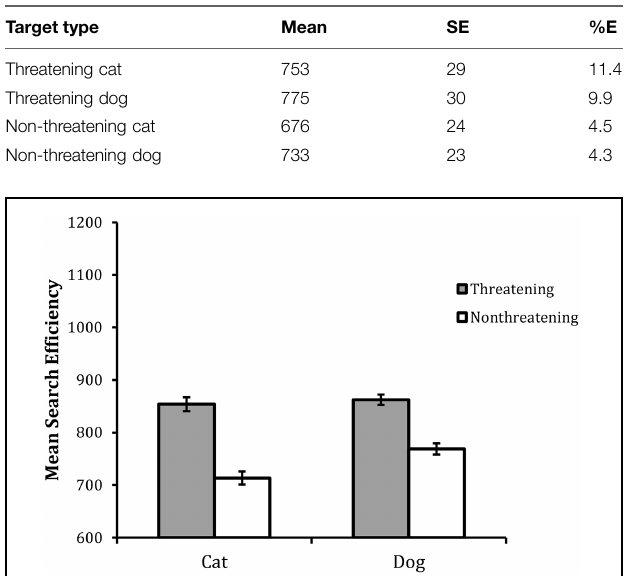
TABLE 5 | Mean RTs, SE, and mean percentage error rates (%E) for the various conditions of interest in the non-search classification task in Experiment 3.